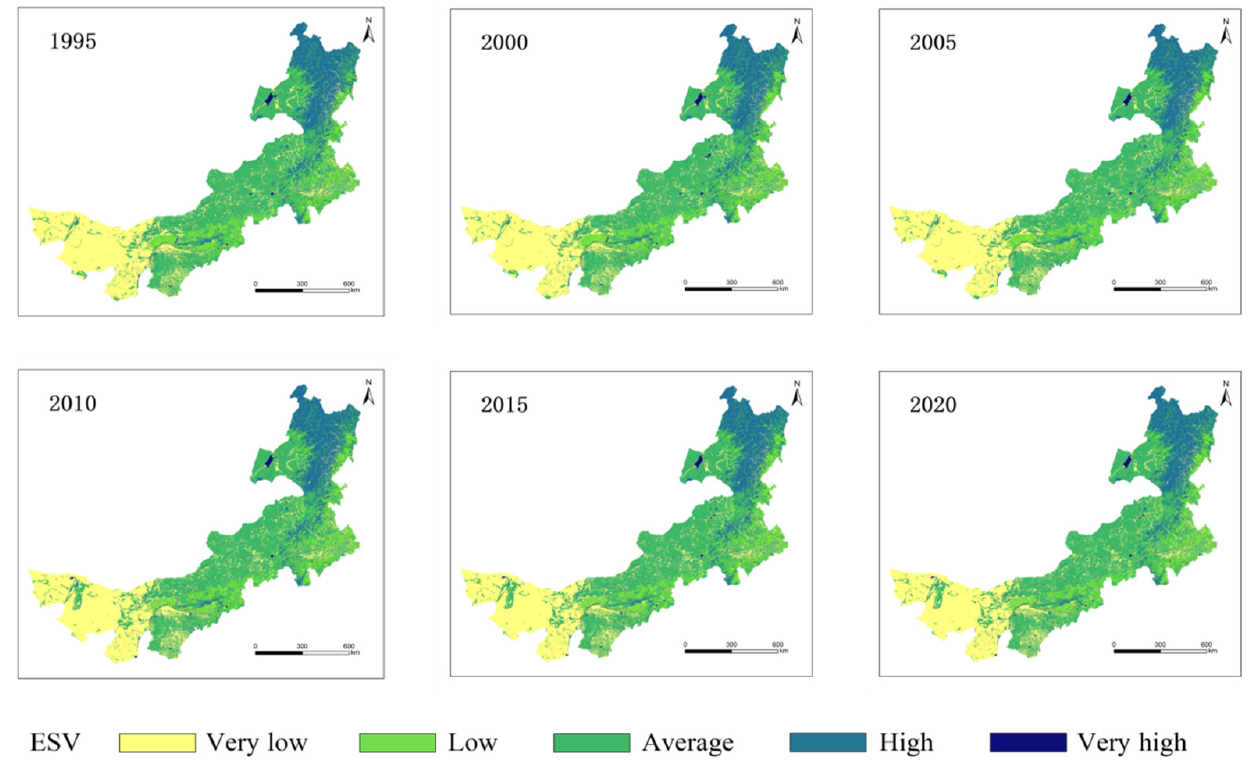
Figure 4. Spatial pattern of total ESV in Inner Mongolia from 1995 to 2020. Table 3. ESV of different ecosystem services in Inner Mongolia (10 8 yuan).